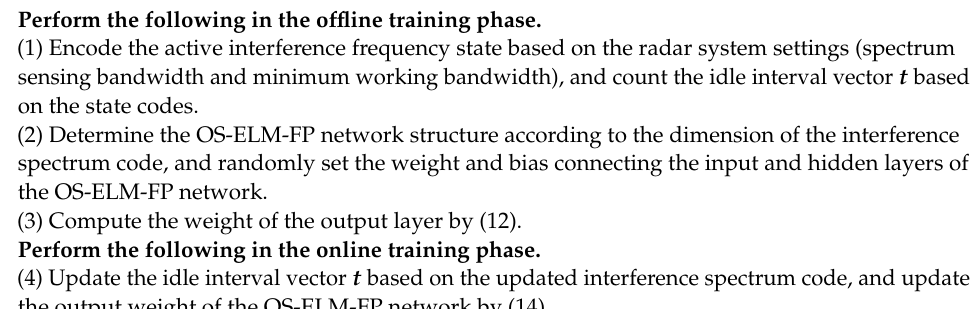
Algorithm 1 OS-ELM-FP-based interference frequency prediction